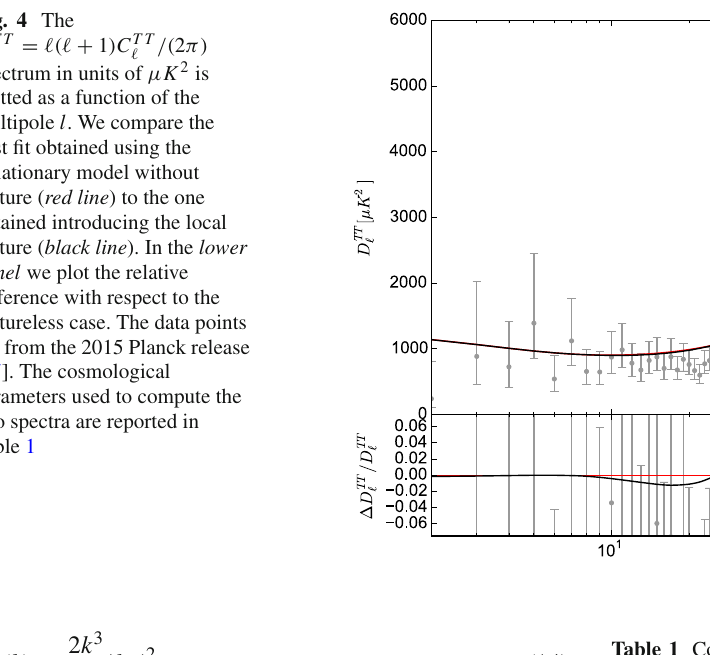
Table 1 Constraints on the cosmological parameters and χ 2 for the model with and without feature. All the constraints are given at 1 σ confidence level. The lower limits on the feature parameters correspond to the limits we used as a prior. The best-fit values are the values inside curly brackets. We separately report the different contributions to the χ 2 (Planck low- (cid:14) , Planck high- (cid:14) and from the priors on the nuisance parameters) and the